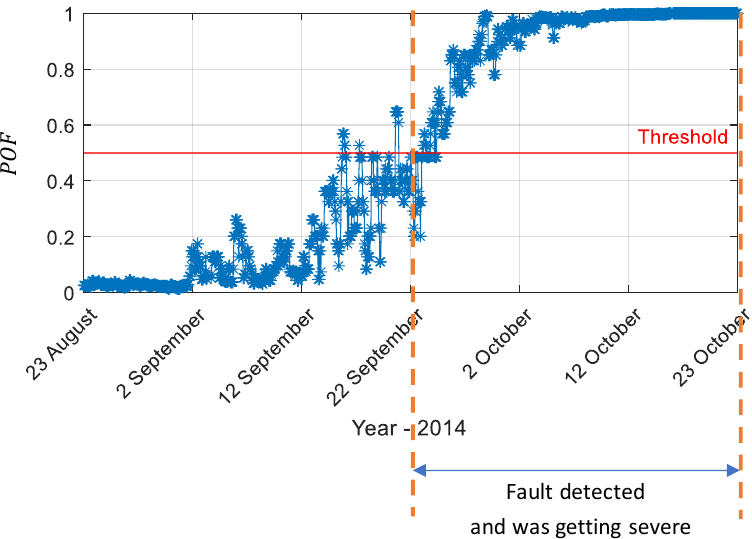
Figure 17. POF of the compressor obtained by SAE in the online phase (red line: fault detection threshold d 1 )